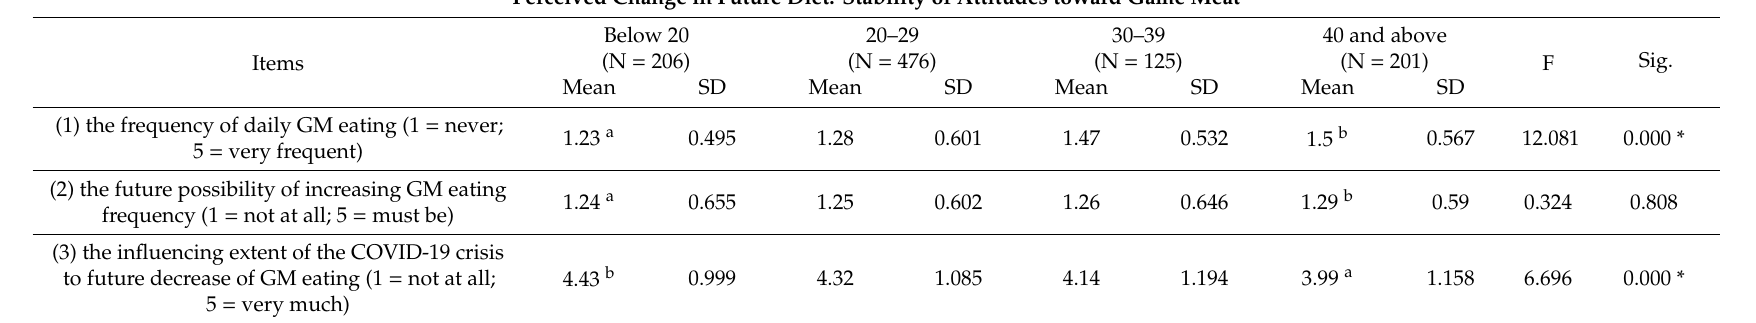
Table 5. The means, standard deviations, and F-tests of di ff erences of the measurement “perceived change in future diet: stability of attitudes toward game meat” across